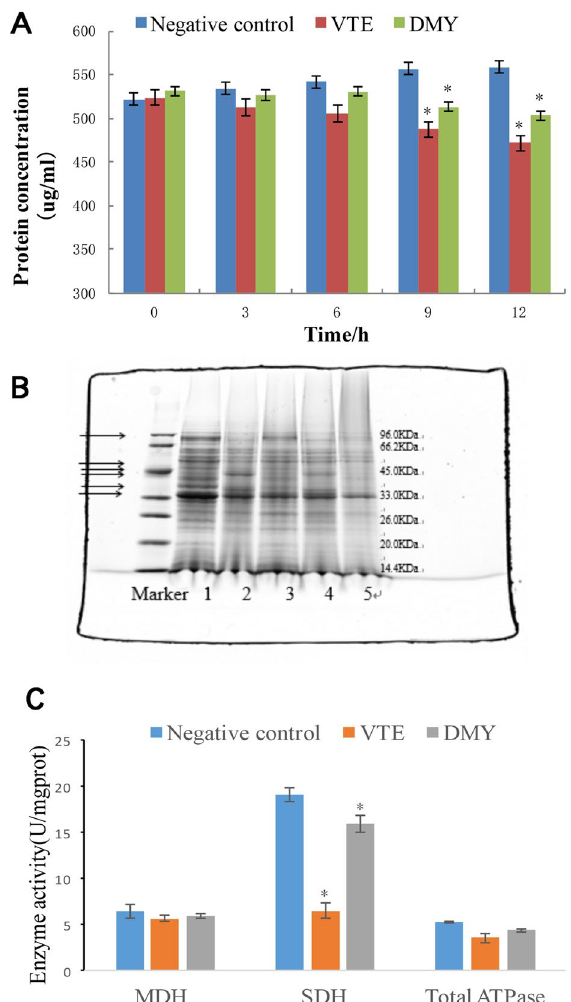
Figure 7. Changes of intracellular protein content in S. aureus treated with inhibitor ( A ). SDS-PAGE electrophoresis diagram of S. aureus under the action of inhibitor: 1. Negative control; 2. DMY-6 h; 3. DMY- 24 h; 4. VTE-6 h; 5. VTE-24 h ( B ). Activity of key enzymes in Energy Metabolism of S. aureus treated with Inhibitors for 12 h ( C